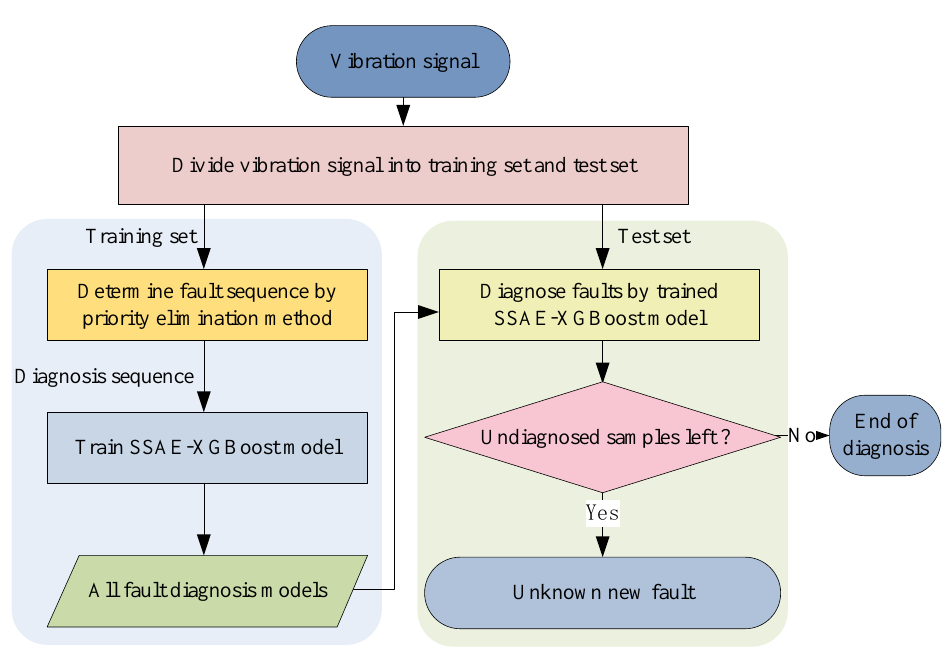
Figure 3. Flow chart of the priority elimination method.